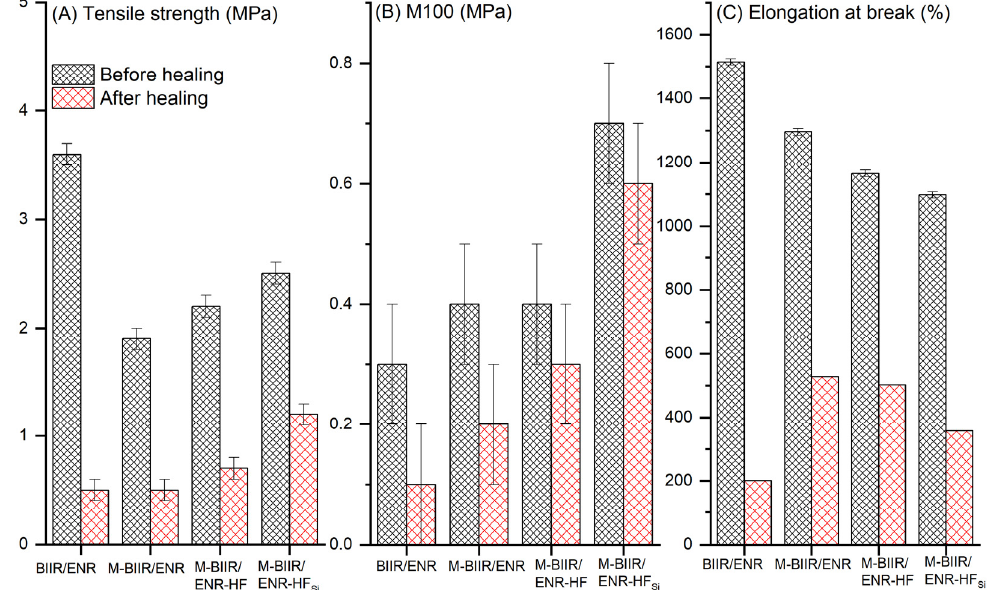
Figure 2. Tensile properties ( A ), modulus at 100% elongation (M100) ( B ) and elongation at break ( C ) of unmodified BIIR and the M-BIIR/ENR composites filled with CNT/CB with and without the addition of TESPT.